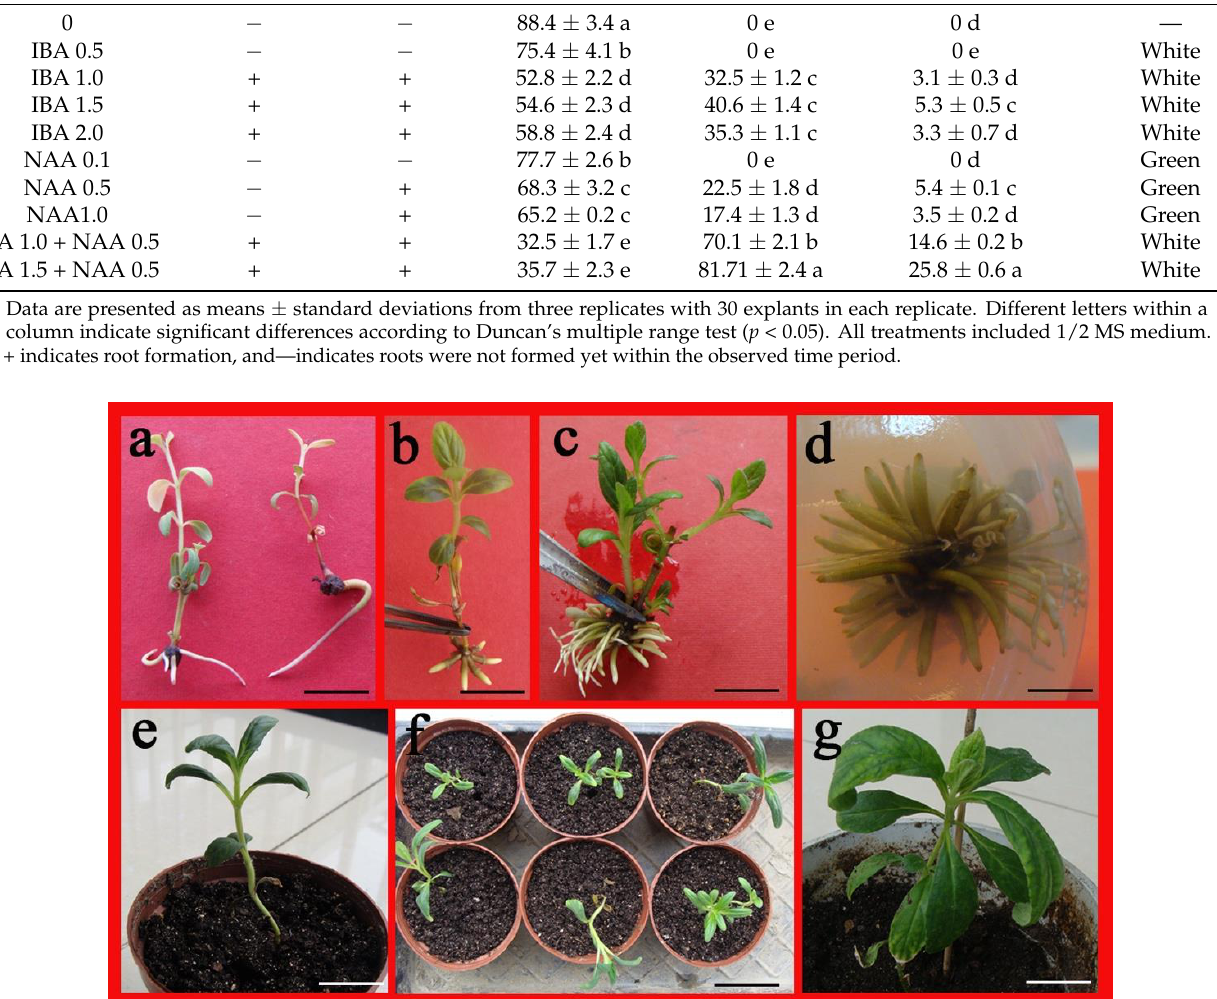
Figure 5. Rooting and transplanting of A. lupulina . ( a – d ) in vitro root production on 1.0 mg L −1 of IBA ( a ), 0.5 mg L −1 of NAA ( b ) and 1.5 mg L −1 of IBA plus 0.5 mg L −1 of NAA and activated charcoal (2 g L −1 ) ( c , d ). ( e , f ) acclimatization of a rooted plantlet in the culture room. ( g ) Completely regenerated plantlets grown in greenhouse. Bar = 1 cm ( a , b , c ), 5 mm ( d ), 2.5 cm ( e ), 1.5 cm ( f ), 3.0 cm ( g ).